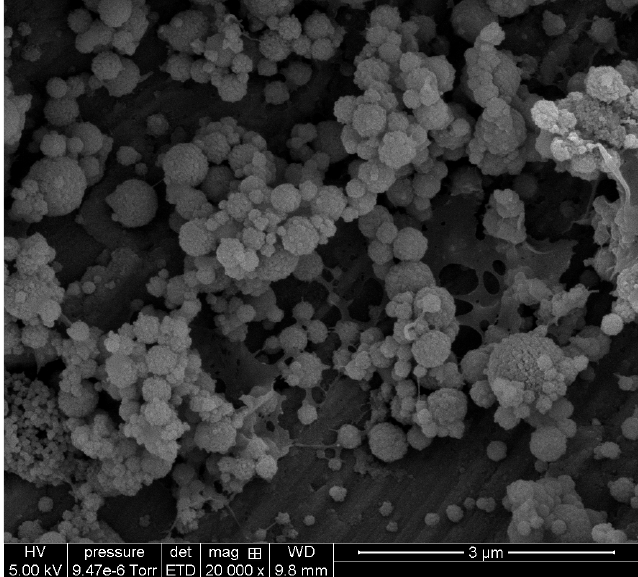
Figure 5. SEM CS-HA 0.01% in water (chitosan: DA 48%, molar mass 130 000 g/mol; hyaluronic acid 50 000 g/mol, R =